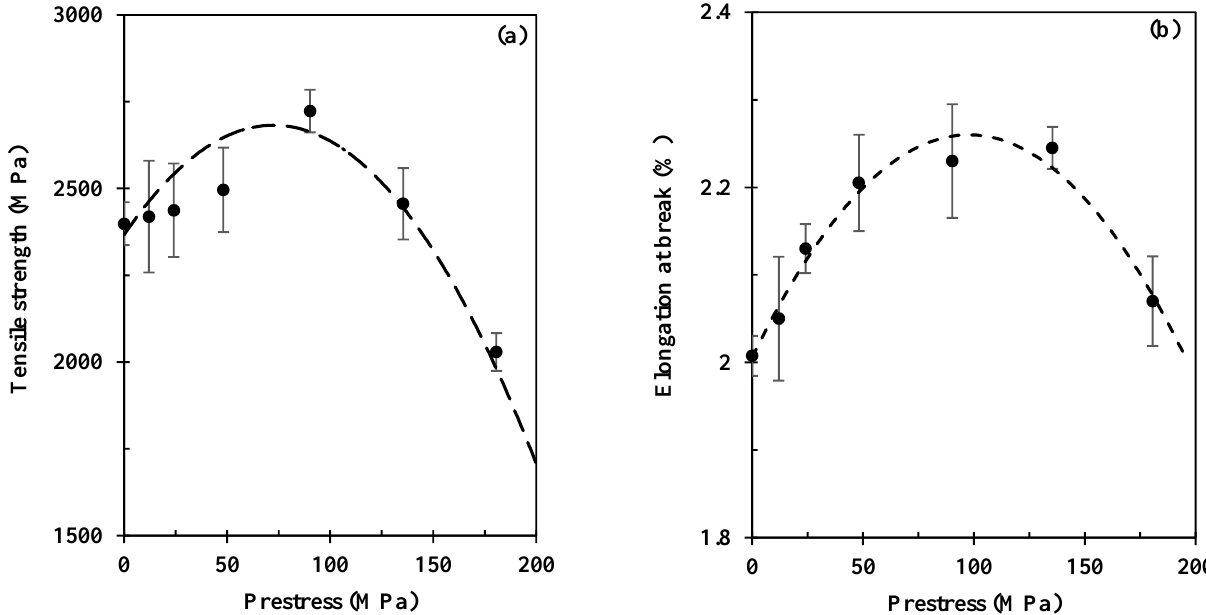
Figure 5. Effects of fibre prestressing level on ( a ) tensile strength and ( b ) elongation at break of the composite. Each case was tested three times, and standard errors are presented by the error bars.